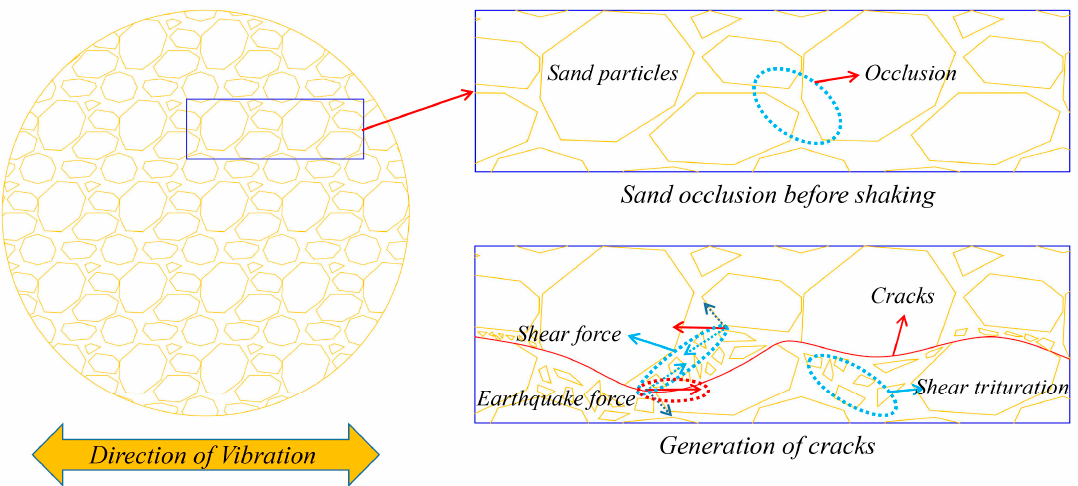
Figure 2. Failure mechanism of prototype sand under horizontal accelerations.